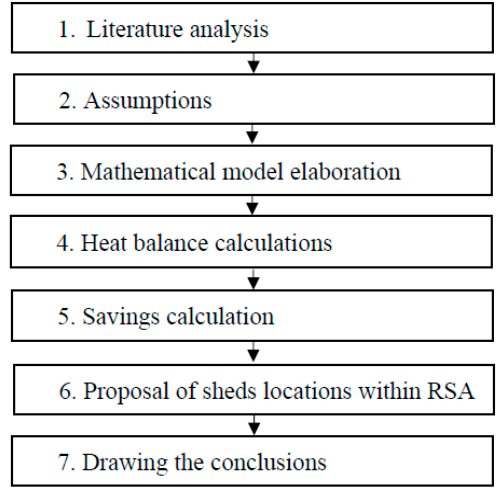
Figure 1. Research methodology.